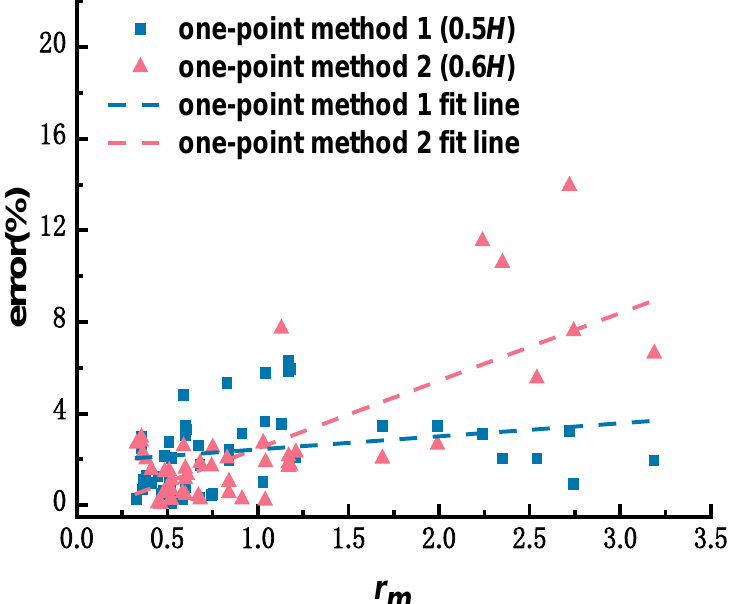
Figure 3. Comparison of velocity-estimation error related to two one-point methods.